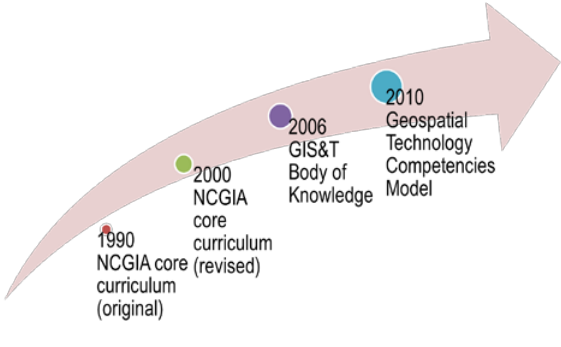
Figure 2: Development of GIScience